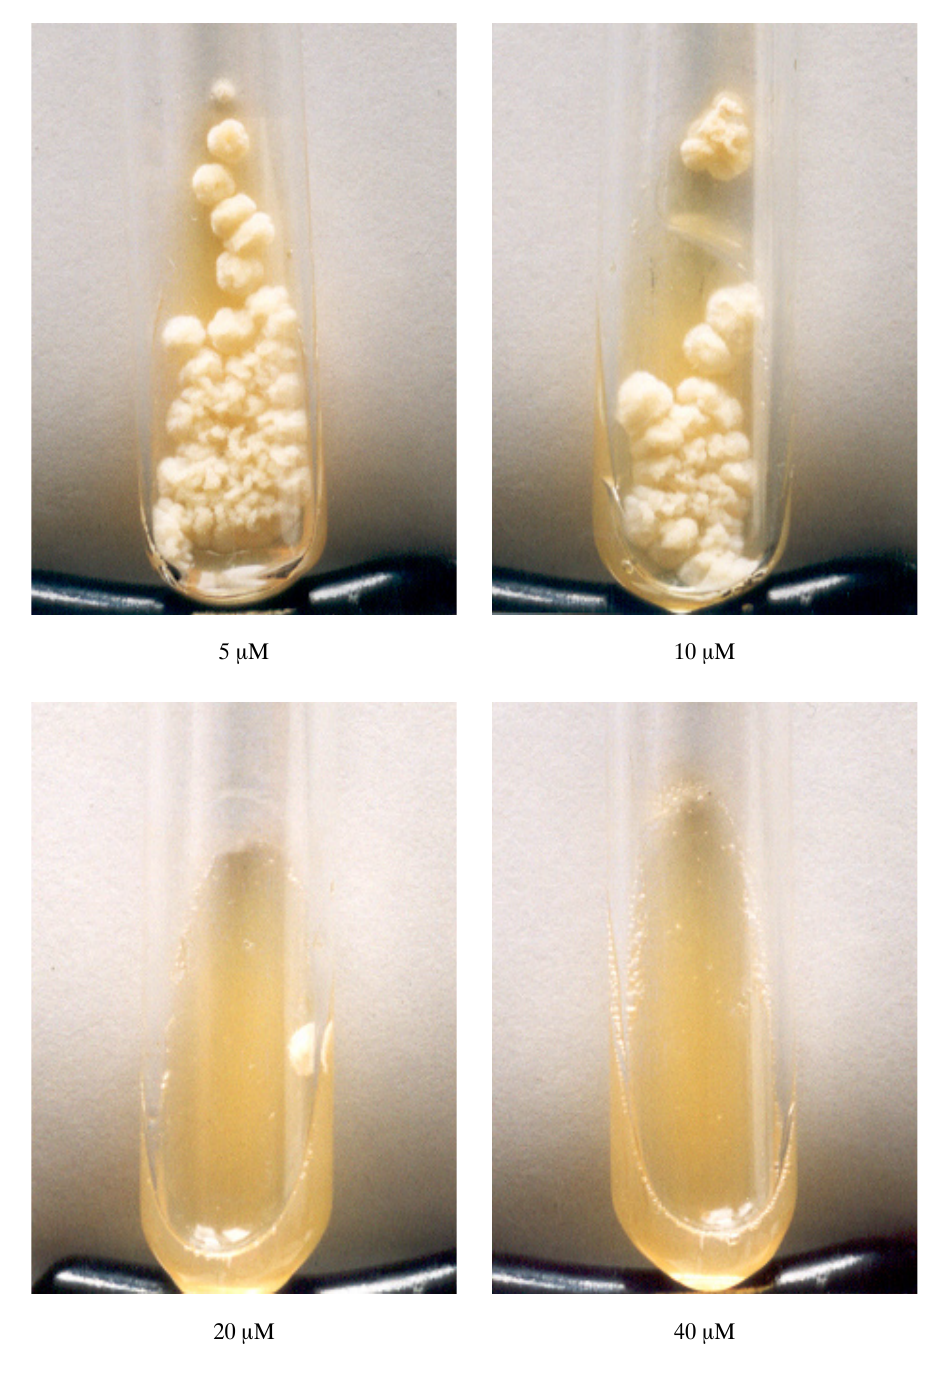
Fig. 6. Growth of Trichosporon cutaneum on the medium YNB at the presence of C14 com- pound and amino